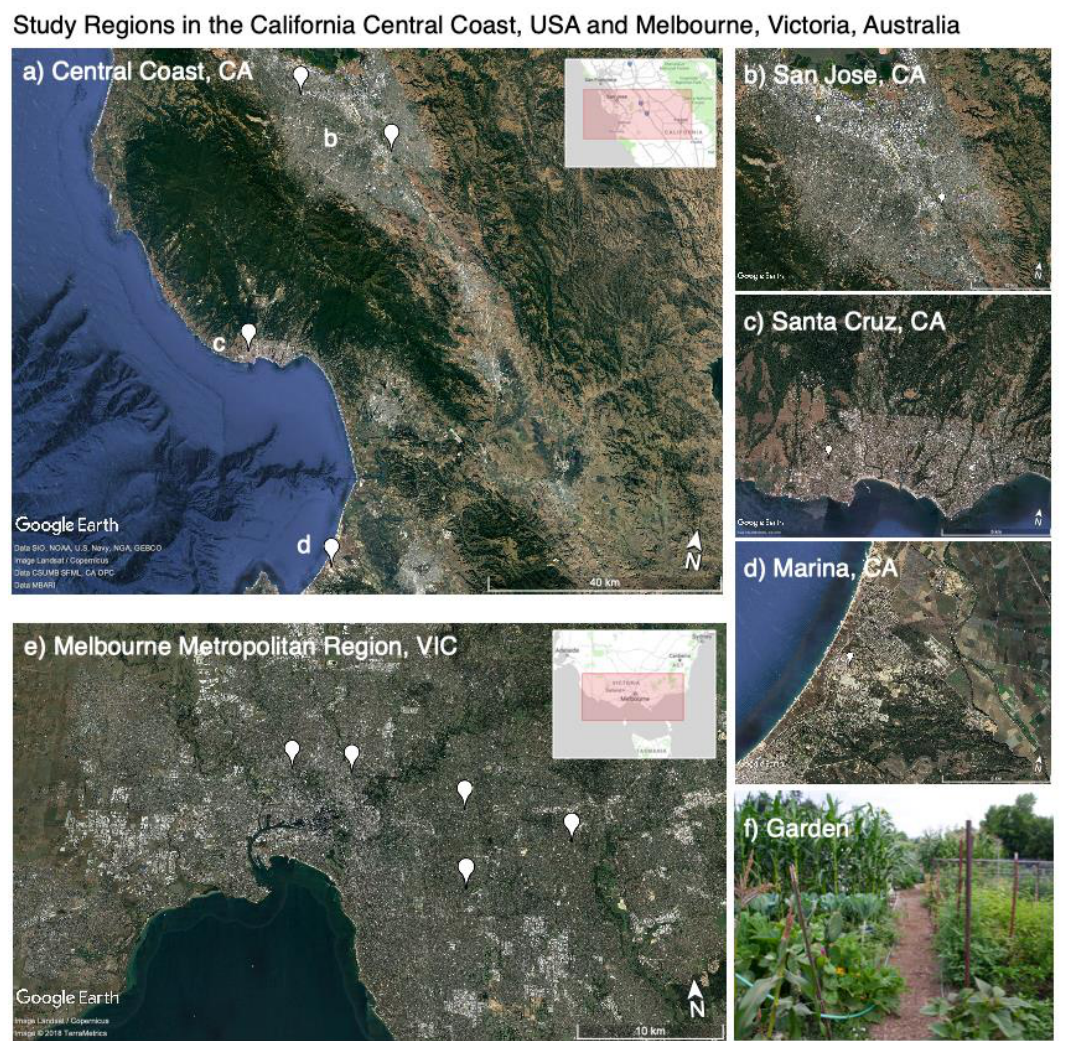
Figure 1. Study regions in the California Central Coast, CA, USA, and Melbourne, Victoria, Australia. Community gardens (white balloons) located in the California Central Coast ( a ) spanning two ecoregions including the Santa Clara Valley ( b ) and the Monterey Bay Plains ( c , d ); Gardens located in the Melbourne Metropolitan Region spanning two ecoregions including the Gippsland Plain and Victorian Volcanic Plain ( e ); an example of a garden in this system ( f ). Images are courtesy of Google Earth satellite imagery [38] and M. Egerer.